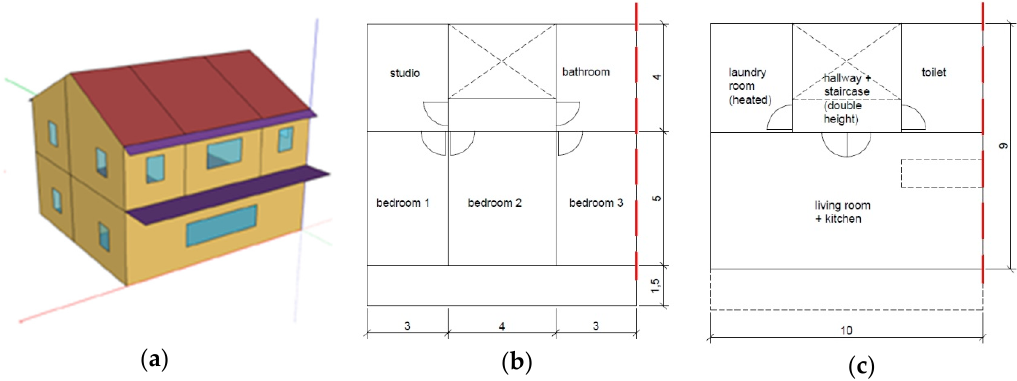
Figure 1. The case-study building. ( a ) Tridimensional model; ( b ) first floor (north is on top); ( c ) ground floor. The red line indicates an adiabatic wall (adjacent building).